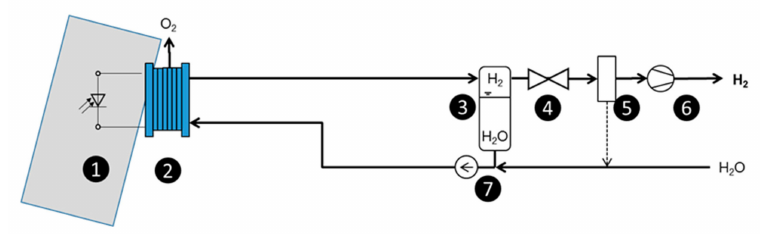
Figure 1. Scheme of an advanced setup: (1) PV module; (2) electrolysis cell / stack; (3) hydrogen separator; (4) valve for pressure control; (5) dehumidification; (6) compressor; (7) water circulation